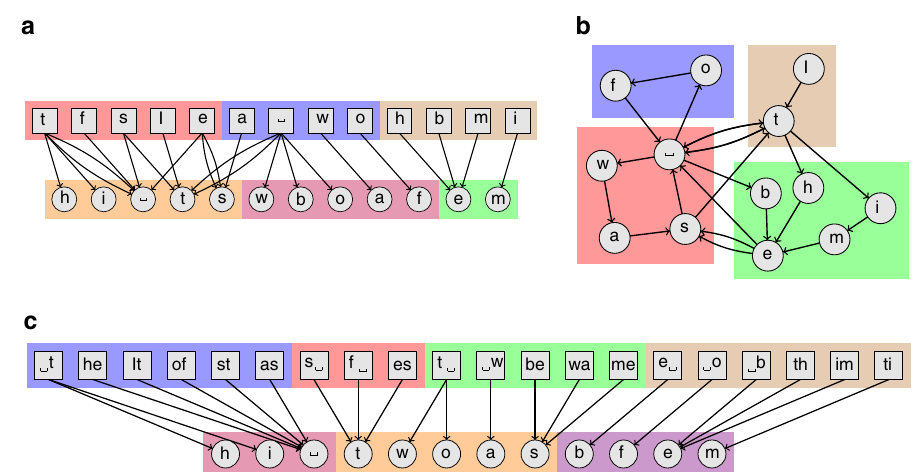
Fig. 2 Schematic representation of the Markov model with communities. The token sequence { x t } = ‘ It was the best of times ’ represented with nodes for memories ( top row ) and tokens ( bottom row ), and with directed edges for transitions in different variations of the model. a A partition of the tokens and memories for an n = 1 model. b A uni fi ed formulation of an n = 1 model, where the tokens and memories have the same partition, and hence can be represented as a single set of nodes. c A partition of the tokens and memories for an n = 2